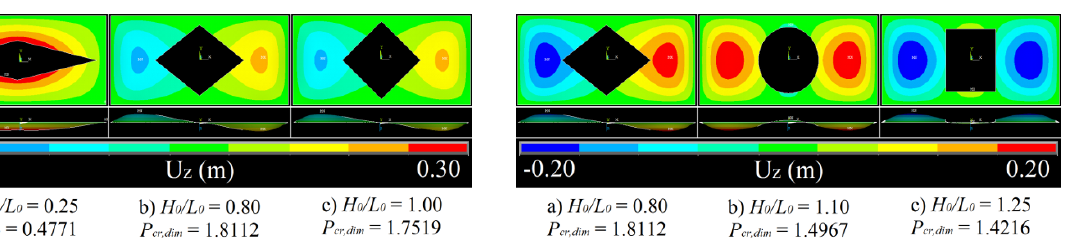
lowing ratios of H 0 /L 0 : 0.25 (Figure 11(a)), 0.80 (Figure 11(b)) and 1.00 (Figure 11(c)).